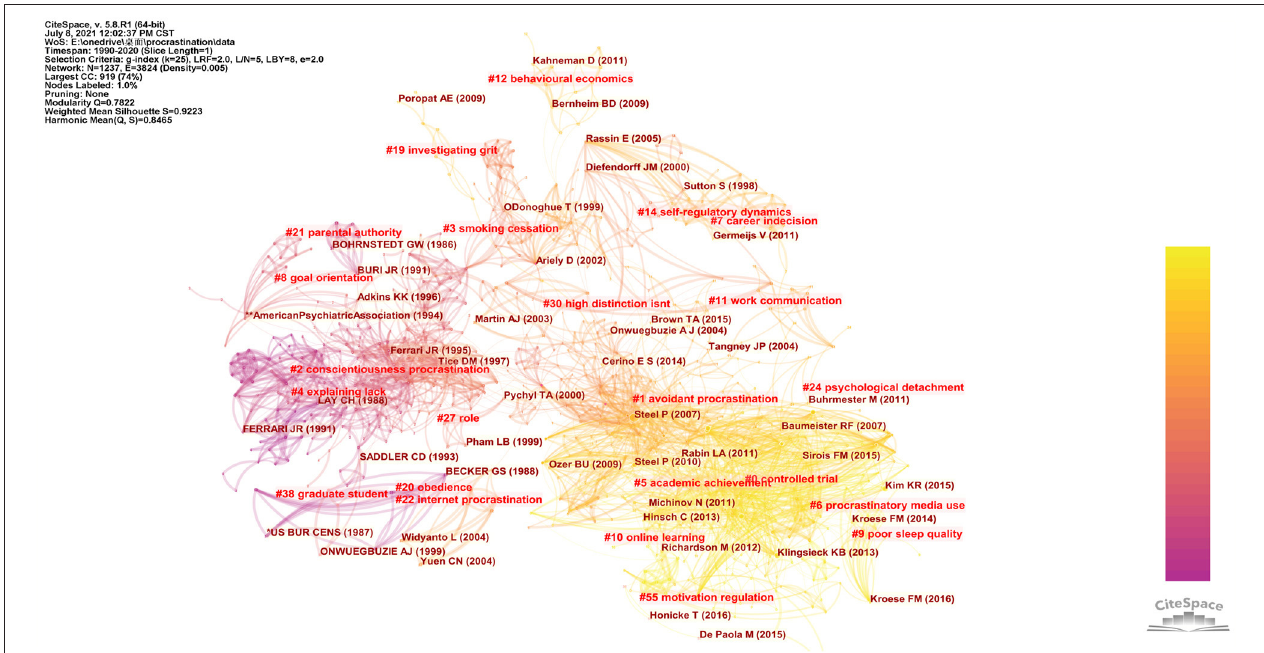
FIGURE 4 | Landscape view of co-citation network of procrastination